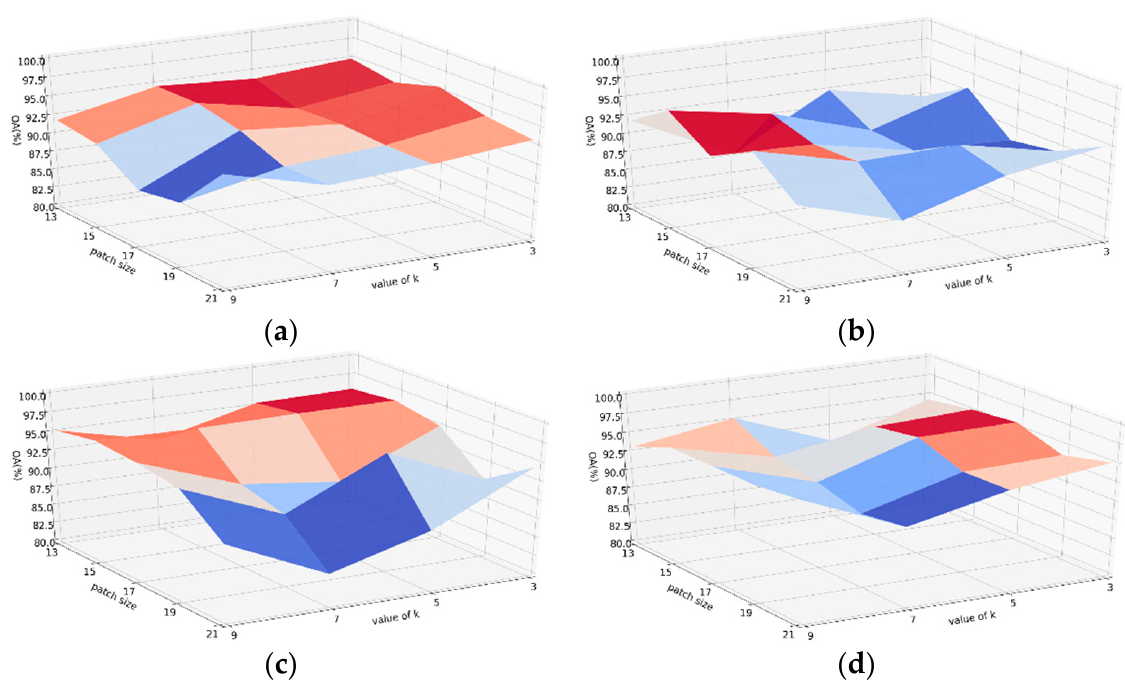
Figure 14. OA with different values of k and patch sizes. ( a ) UP. ( b ) SV. ( c ) HOU. ( d )